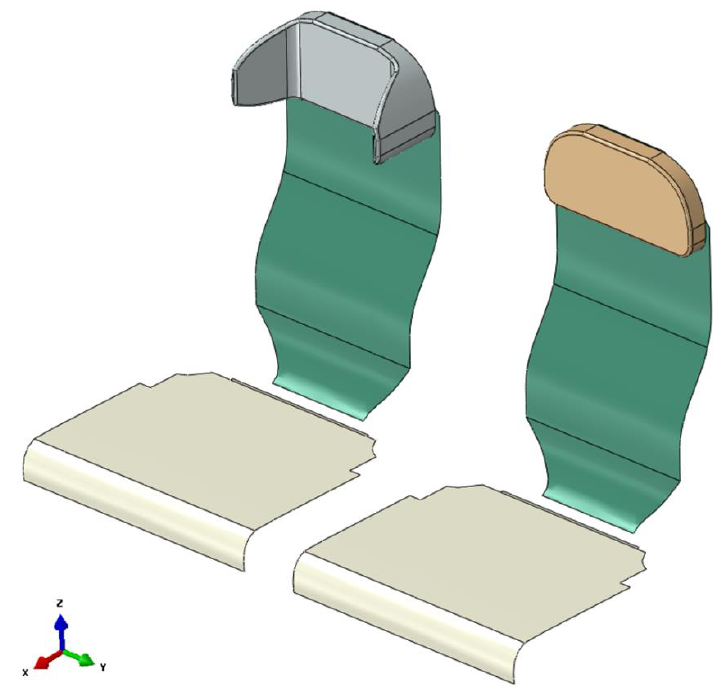
Figure 3. Simplified CAD models, considering both flat ( right ) and folded ( left ) headrest.